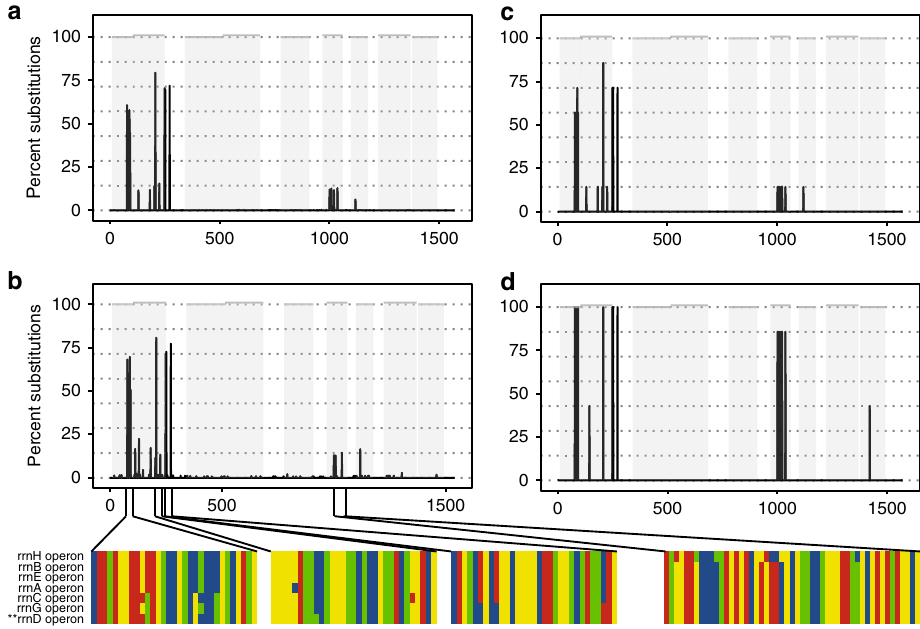
Fig. 2 Polymorphisms in E. coli 16S rRNA gene sequences. a The position and frequency of substitutions appearing in E. coli strain K-12 MG1655 V1 – V9 amplicons generated from our mock community and sequenced on the PacBio RS II platform. b The position and frequency of substitutions in reads generated from genomic sequencing of the isolated E. coli strain K-12 MG1655 on the Illumina MiSeq platform. Magni fi ed regions show respective positions in the alignment of all seven 16S genes present in the E. coli K-12 MG1655 reference genome. The 16S sequence from the rrnD operon (**) is used as the reference for all SNP phasing. c The predicted nucleotide substitution pro fi le of E. coli K-12 MG1655 based on aligning the seven 16S gene sequences present in the reference genome. d The predicted substitution pro fi le of E. coli O157 Sakai based on aligning the seven 16S gene sequences present in the reference genome. Gray panels depict variable regions de fi ned by commonly used primer-binding sites (Supplementary Table 1). Dashed lines indicate the expected proportion of nucleotide substitutions, given there are seven 16S gene copies within each genome. Source data are provided as a Source Data fi